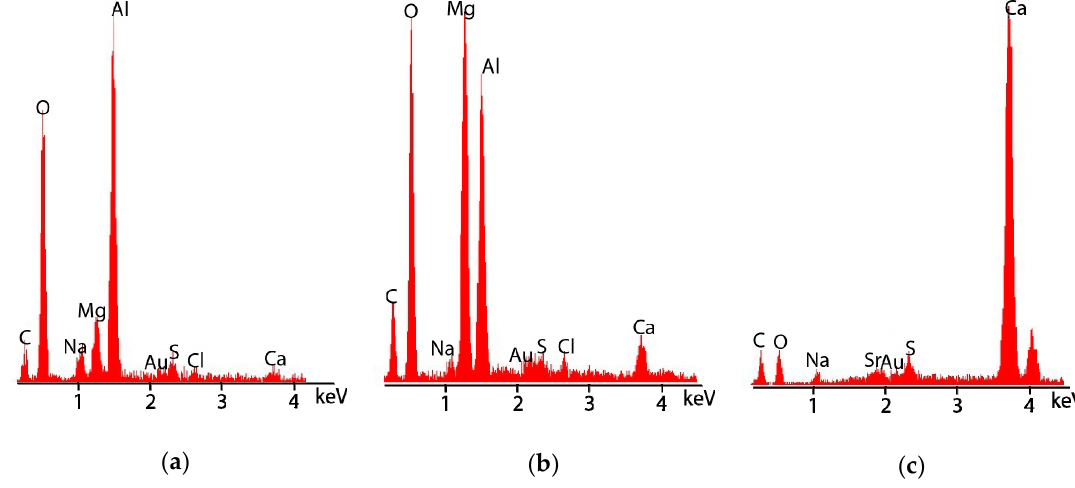
Figure 12. EDX spectra showing elemental composition of regions ( a ) 1, ( b ) 2 and ( c ) 3 of Figure 11.